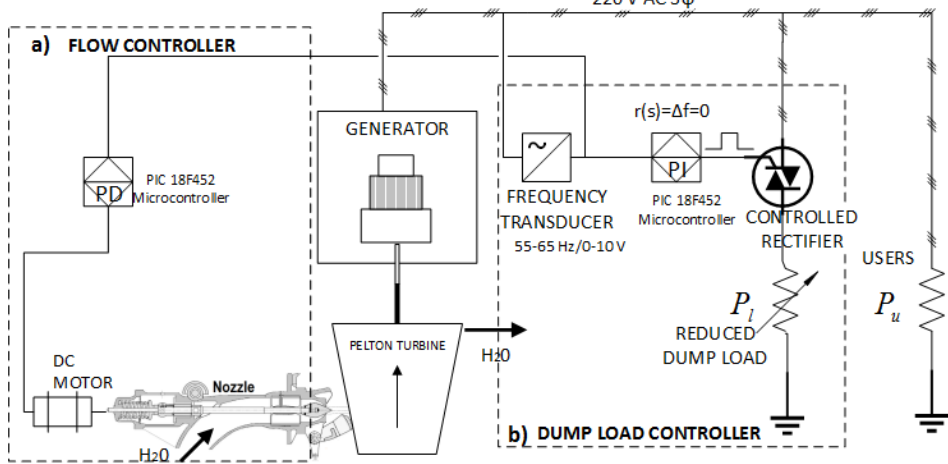
Figure 2. Proposed combined regulation scheme for AMHPP frequency control. ( a ) Flow control, ( b ) Dump load control. ( b ) Dump load